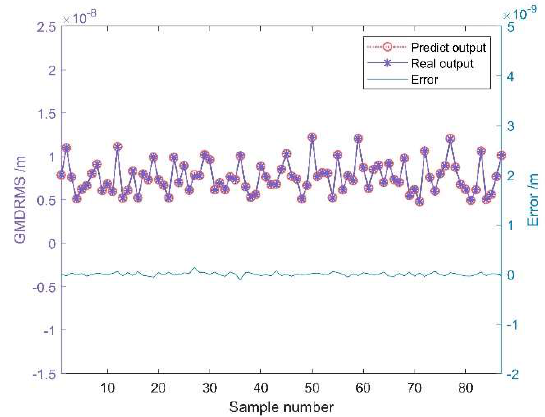
Figure 11. The comparison of the results of the GMDRMS test set.